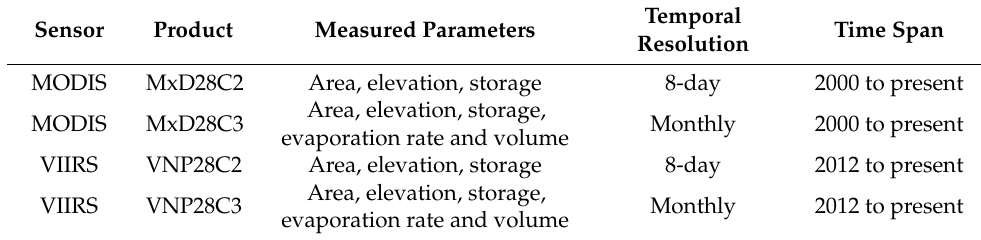
Table 2. Overview of the reservoir product